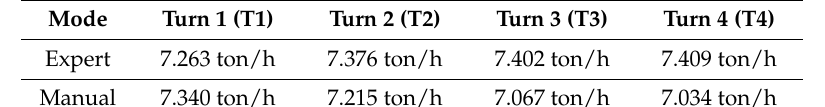
Table 9. Turn-based performance in both modes.